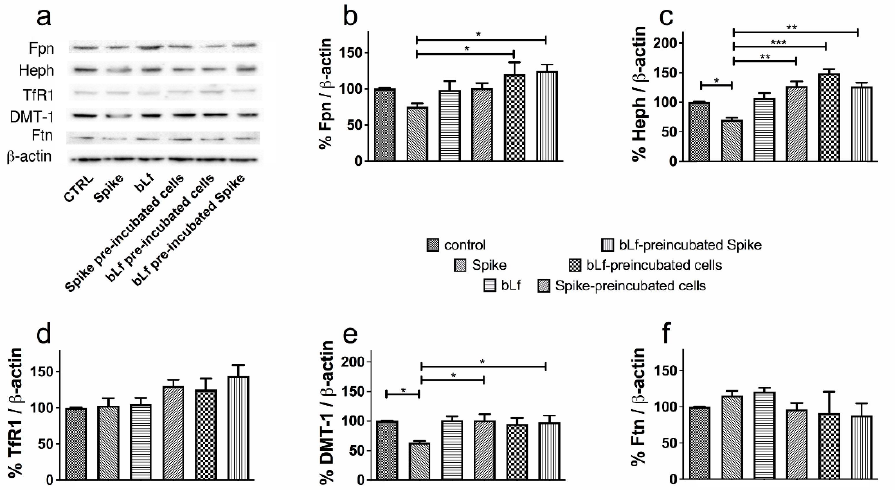
Figure 4. Protective effect of bovine lactoferrin (bLf) against iron and inflammatory disorders induced by SARS-CoV-2 Spike glycoprotein on Caco-2 cells. Western blot (panel ( a )) and densitometry analysis of ferroportin (Fpn) ( b ), hephaestin (Heph) ( c ), transferrin receptor 1 (TfR1) ( d ), DMT-1 ( e ) and ferritin (Ftn) ( f ) levels in Caco-2 cells untreated or treated with 20 nM Spike glycoprotein in the absence or presence of 1.25 μ M bLf. See text for details. Error bars: standard error of the mean. Statistical significance is indicated as follows: *: p < 0.05; **: p < 0.01; ***: p < 0.001 (one-way ANOVA with post-hoc Tukey test).